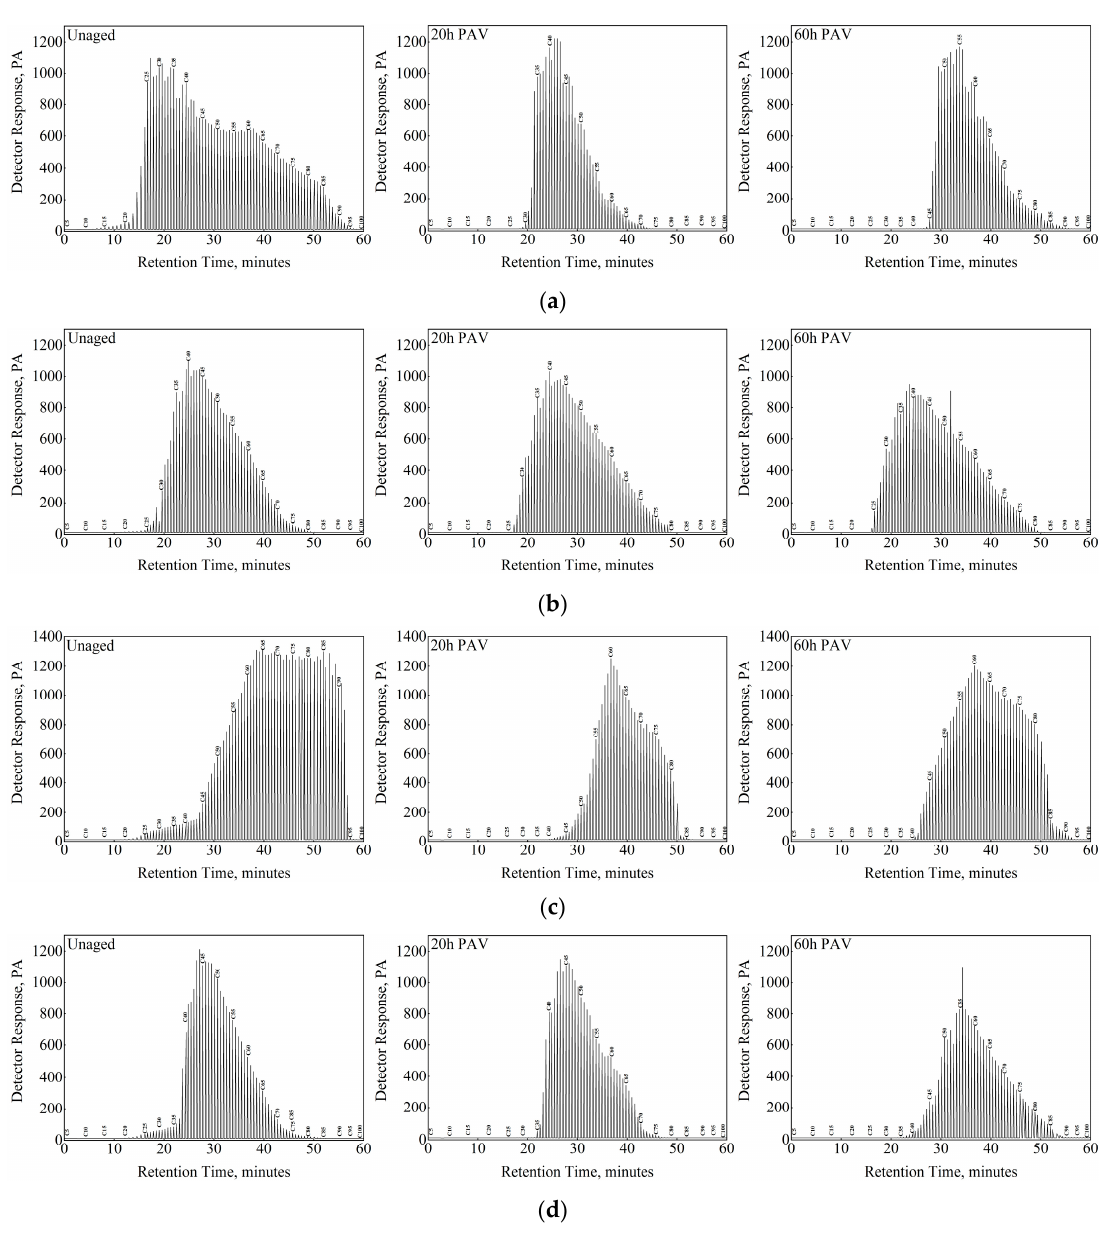
Figure 5. Gas chromatogram of asphalt binders. ( a ) ABG, ( b ) AAV, ( c ) AAM-1, and ( d ) AAC-1.